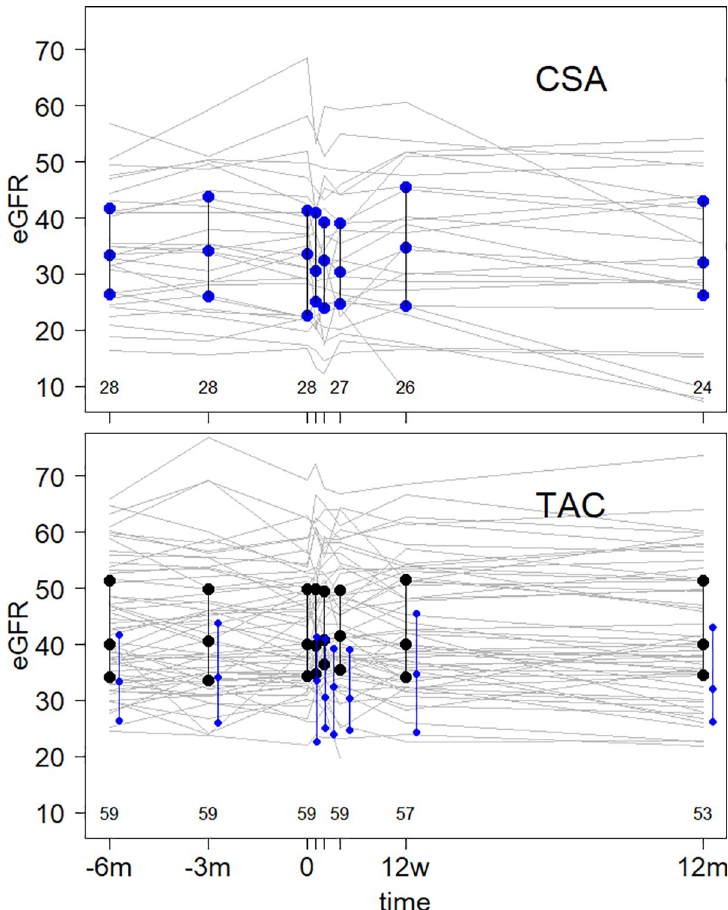
Fig 4. Trajectories of kidney graft function in 87 kidney transplant recipients before and during the first year after conversion from CSA (n = 28) and TAC (n = 59) to TAC MR 4 (median and interquartile range). CSA = ciclosporin A, TAC = tacrolimus, TAC MR4 = tacrolimus modified release, eGFR = estimated glomerular filtration rate, m = month, w = week. The upper field depicts the trajectories in the CSA group (median and interquartile range; blue dots and lines), in the lower field these are superimposed on the trajectories in the TAC group (median and interquartile range; black dots and lines). The x-axis denominates the points in time and the number of compiled eGFR-measurements (in weeks 1 and 2 omitted due to shortage of space. Week 1: CSA n = 25, TAC = 55. Week 2: CSA n = 27, TAC n =